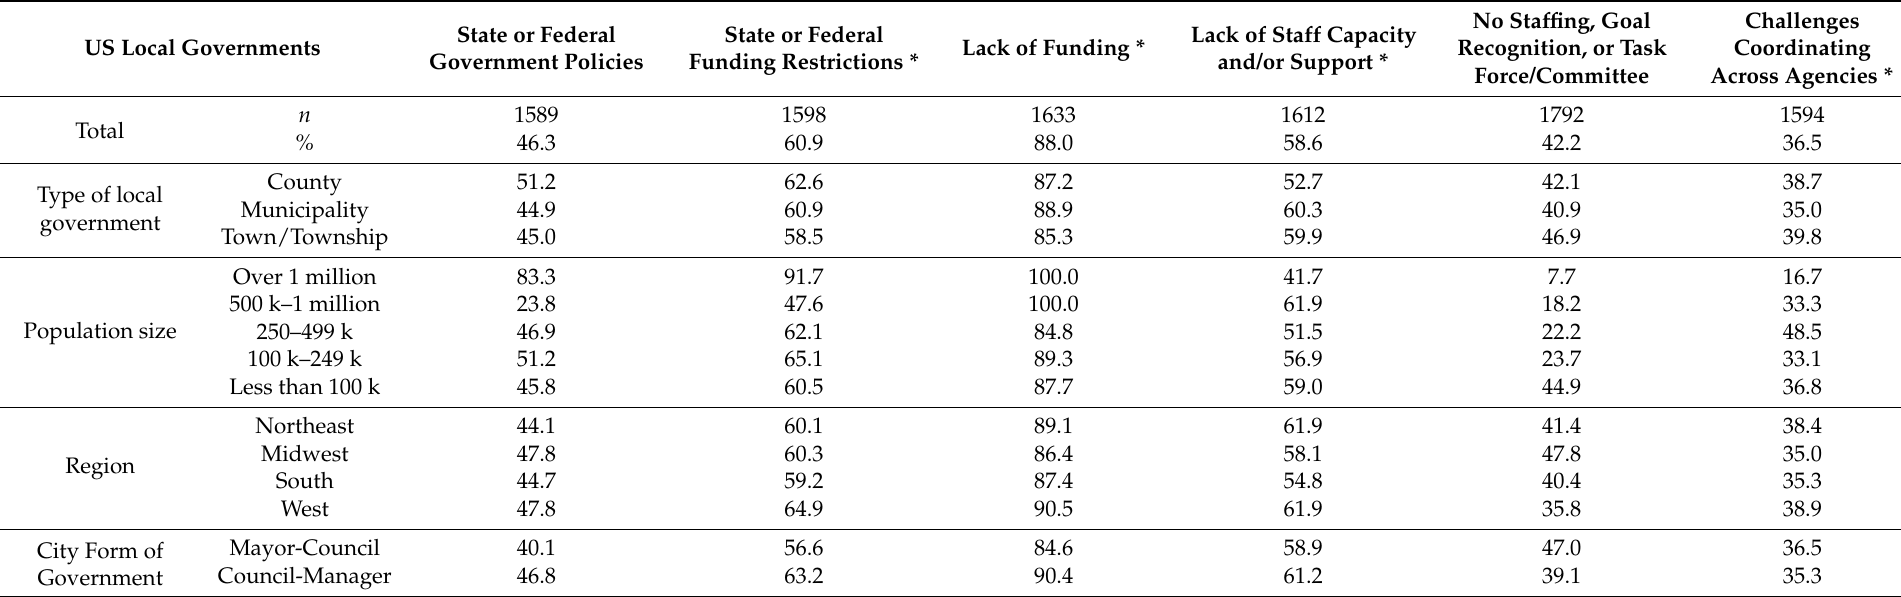
Table 6. Factors that Hinder Sustainability Efforts in U.S. Local Governments, 2015. Percent responding yes. * Percent responding “very significant” or “significant”. Source: International City/County Management Association, Local Government Sustainability Practices Survey